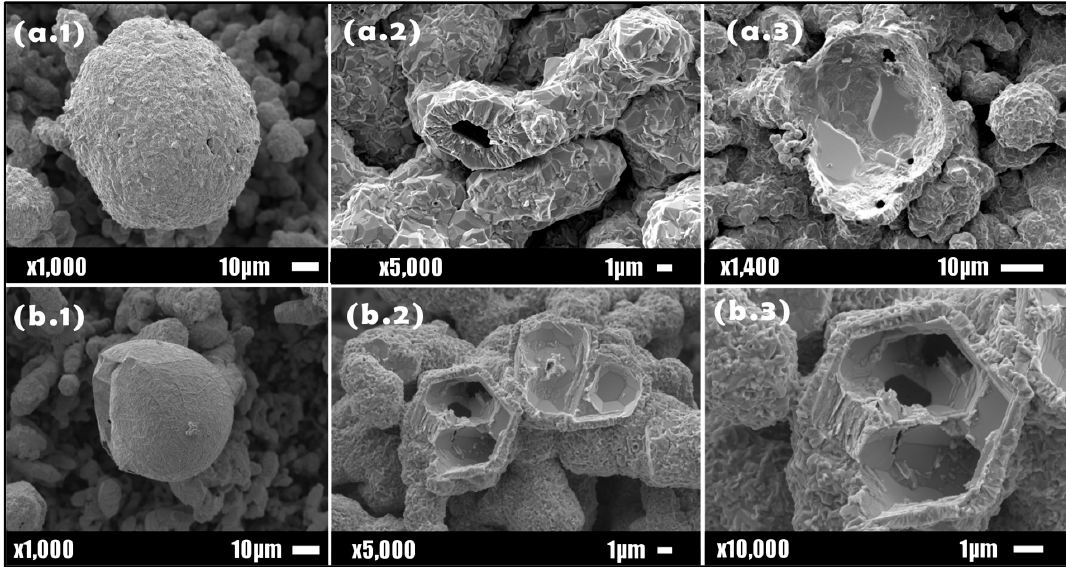
Figure 9. High-resolution field emission (FE) SEM measurements for ( a.1 – a.3 ) undoped ZnO film, and ( b.1 – b.3 ) ZnO:Ta-doped film in different zones of scanning, grown with 300 mg of Ta 2 O 5 in the pellet.